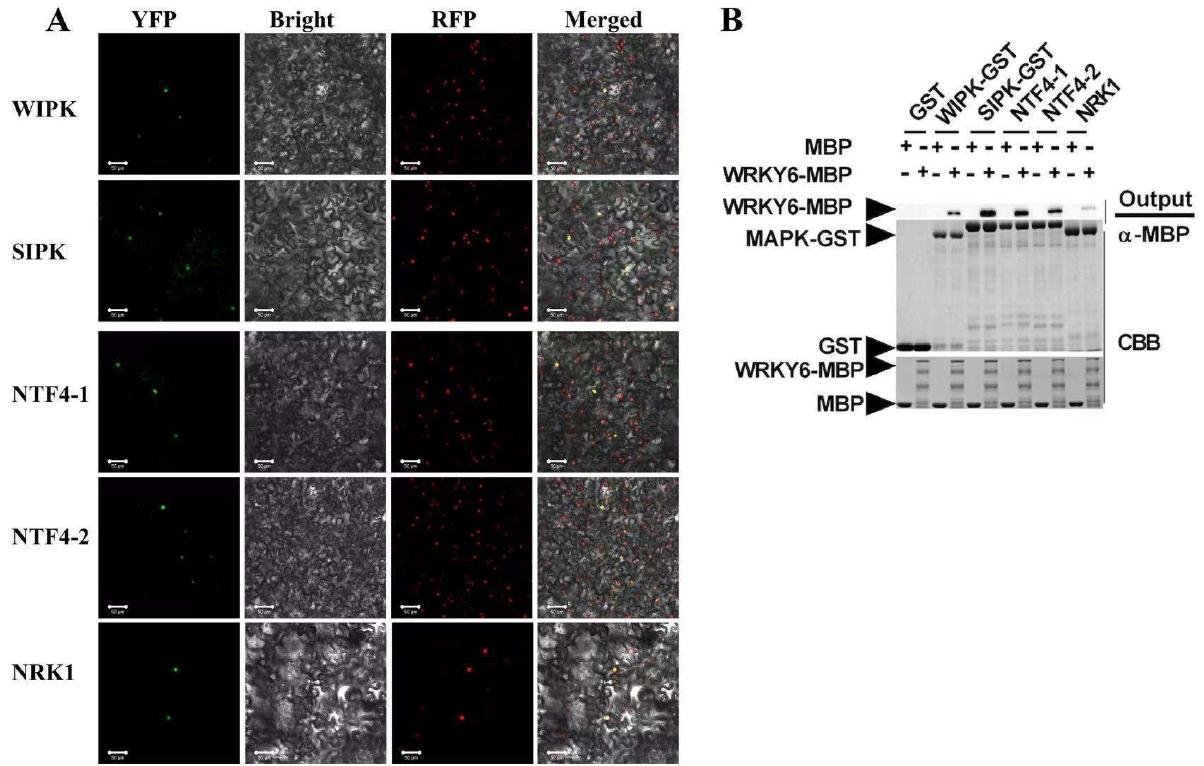
Figure 4. The interactions between NtWRKY6 and five tobacco MAPKs, wound-induced protein kinase (WIPK), salicylic acid-induced protein kinase (SIPK), NTF4-1, NTF4-2, and NRK1. ( A ) In vivo interaction between WRKY6 and NtMAPKs as shown by BiFC analysis. NtWRKY6-YFPN and NtMAPKs-YFPC were transiently co-expressed in N. benthamiana line H2B-RFP, of which the nuclei were marked with RFP fusion protein. Photos were imaged at 48 h using a Zeiss LSM710 confocal microscope. Columns from left to right represent YFP fluorescence, bright field, RFP fluorescence, and YFP/RFP/bright field overlay. Scale bars: 50 μ m. ( B ) In vitro interaction between NtWRKY6 and NtMAPKs as shown by pull-down assay. Proteins GST, NtMAPKs-GST, MBP, and NtWRKY6-MBP were expressed via prokaryotic expression, and purified using glutathione agarose beads or Amylose resin. GST or NtMAPK-GST fusion proteins were used to pull down MBP or NtWRKY6-MBP fusion proteins. Binding proteins were analyzed via SDS-PAGE and Western blot assays using anti-MBP antibodies. At the start, samples (Input) were stained with Coomassie blue solution. GST and MBP proteins were used as negative controls.